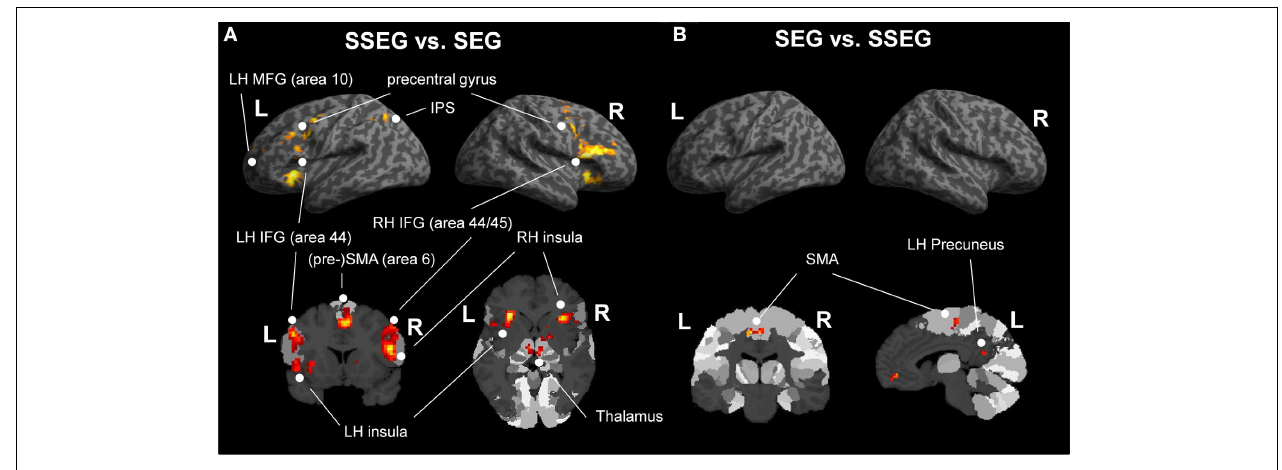
FIGURE 5 | (A) Comparison of suprasegmental vs. segmental condition (uncorrected p < 0 . 001, k = 10 voxels). (B) Segmental vs. suprasegmental condition (uncorrected p < 0 . 001, k = 10 voxels). IFG, inferior frontal gyrus;